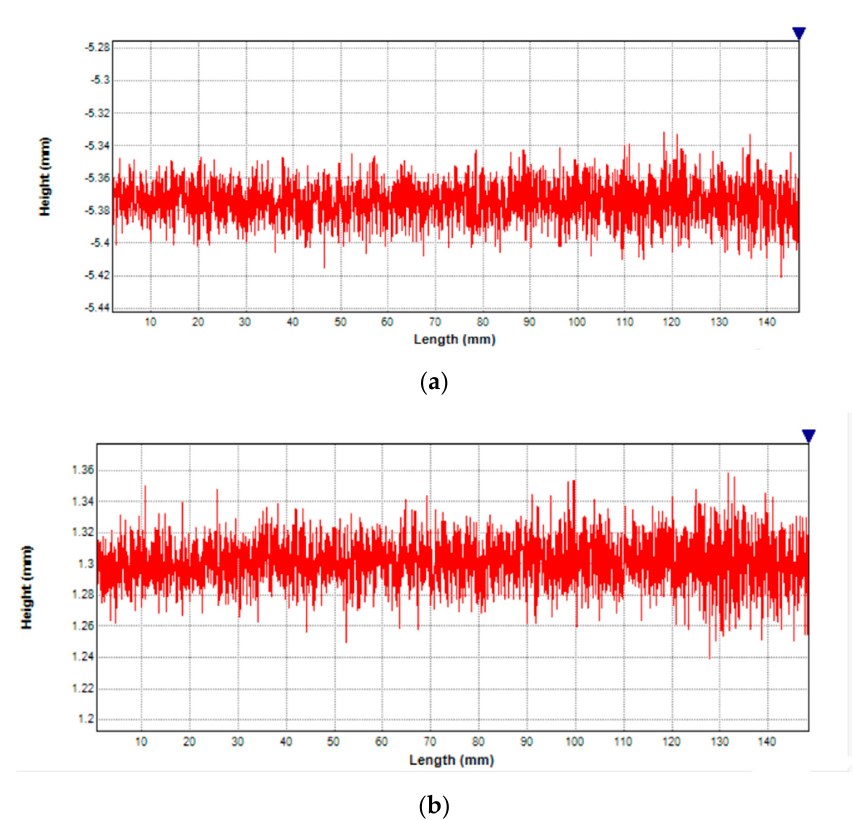
Figure 10. Compared measured distance along one row near the middle of the white plate results, where the X axis represents the width and the vertical axis is the reconstructed depth of the surface: ( a ) z = − 5.4 mm; and ( b ) z = 1.3 mm. Table 2. Details of the accuracy and precision along the depth direction.